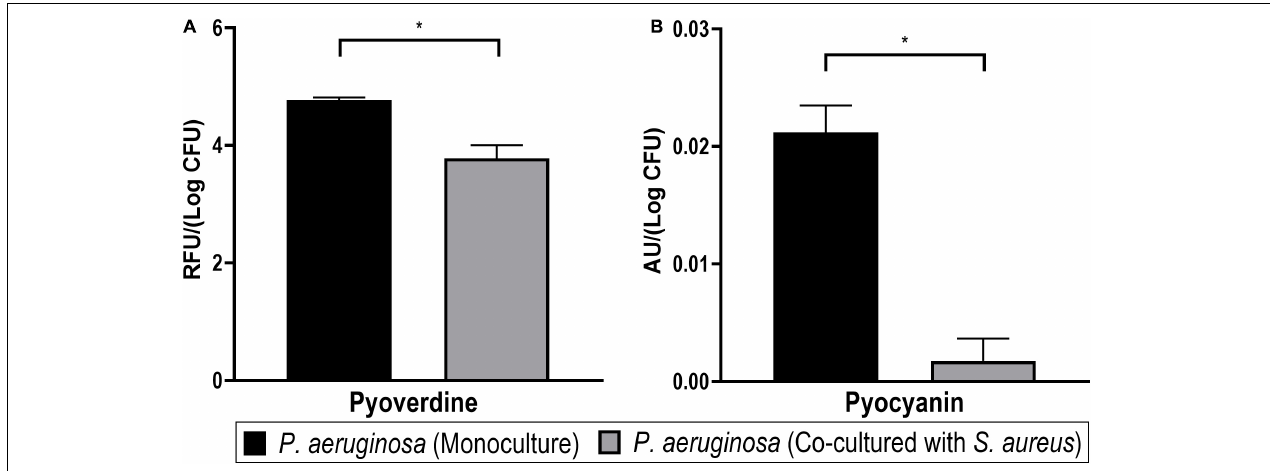
FIGURE 11 | Pigment production of Pseudomonas aeruginosa in mono- and dual-species biofilms. Significant differences of both pyoverdine (A) and pyocyanin (B) pigments were detected between both cultures (Student’s t -test, * p < 0.05). Bars represent the average of two biological repetitions with their